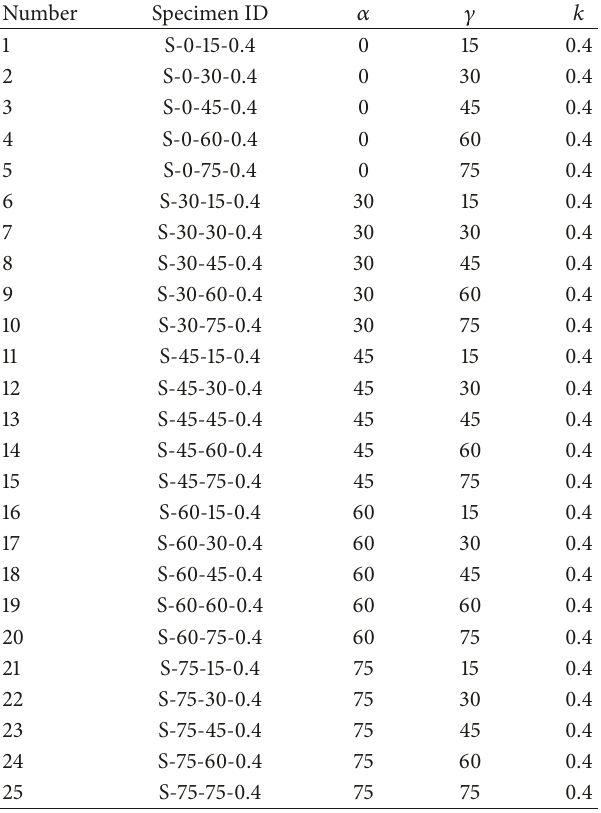
Table 1: Specimen numbers and fissure geometrical parameter values used for specimens with different 𝛼 and 𝛾 .